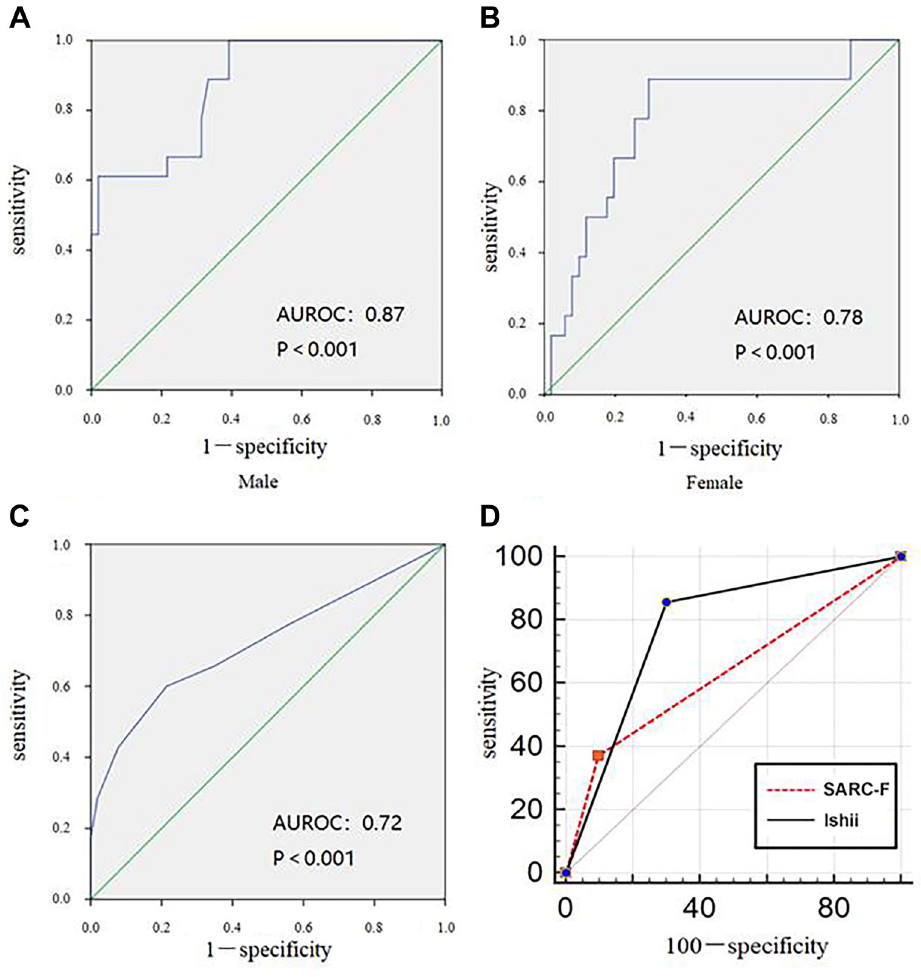
Figure 1. Receiver operating curve (ROC) of Ishii ’ s score in males ( A ) and females ( B ). ROC for the SARC-F score ( C ). Comparison of ROC between the SARC-F and Ishii ’ s scores for the screening for sarcopenia ( D